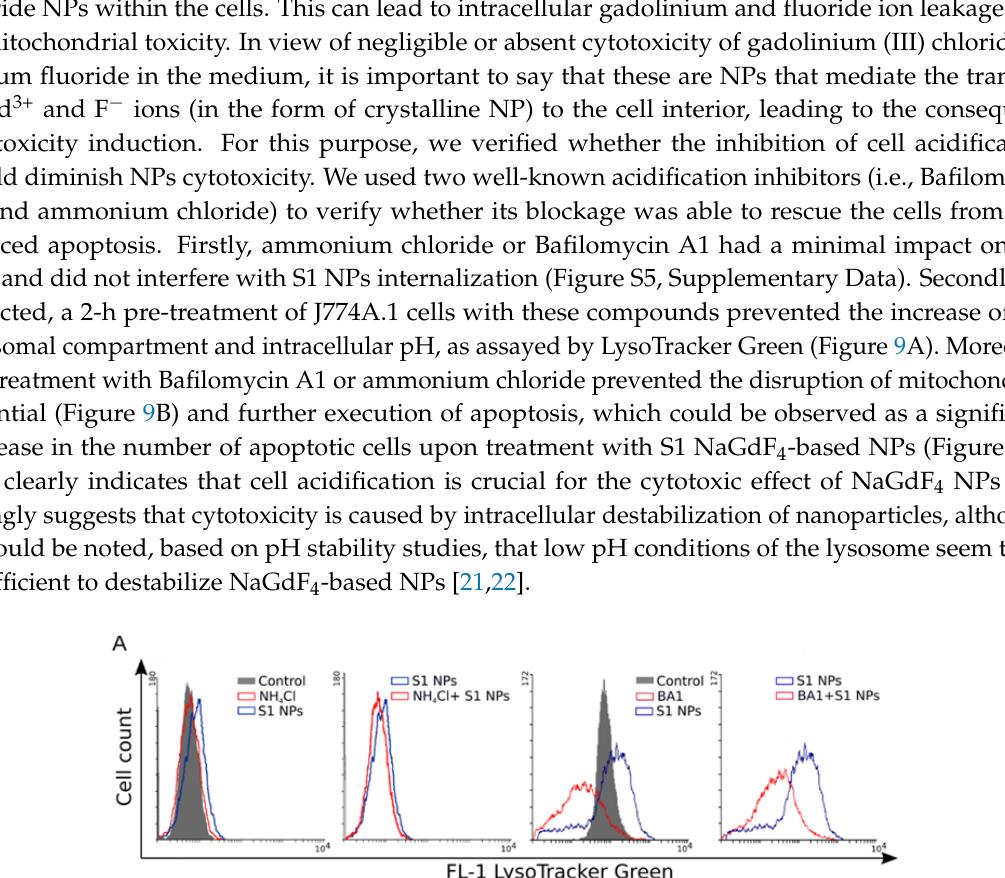
Figure 9. The effect of acidification inhibition of the cells on apoptosis induced by NaGdF4 ‐ based nanoparticles (2.5 μ g/mL). ( A ) 5 nM Bafilomycin A1 (BA1) or 5 mM NH 4 Cl prevents acidification detected by Lysotracker green; ( B ) dot ‐ plot analysis of the mitochondrial potential (MMP) measured using the JC ‐ 1 mitochondrial probe. Representative dot plots are shown; ( C ) Dot plot analysis of Annexin V and propidium iodide staining indicating the apoptotic process. Representative dot ‐ plots are shown. Bar graphs show the analysis of 3 independent experiments. The average of apoptotic cells are shown (AnnexinV+/PI − and AnnexinV+/PI+) ± SD. * p < 0.05; ** p < 0.01; *** p < 0.001. All comparisons were performed with respect to S1 NPs treated cells.